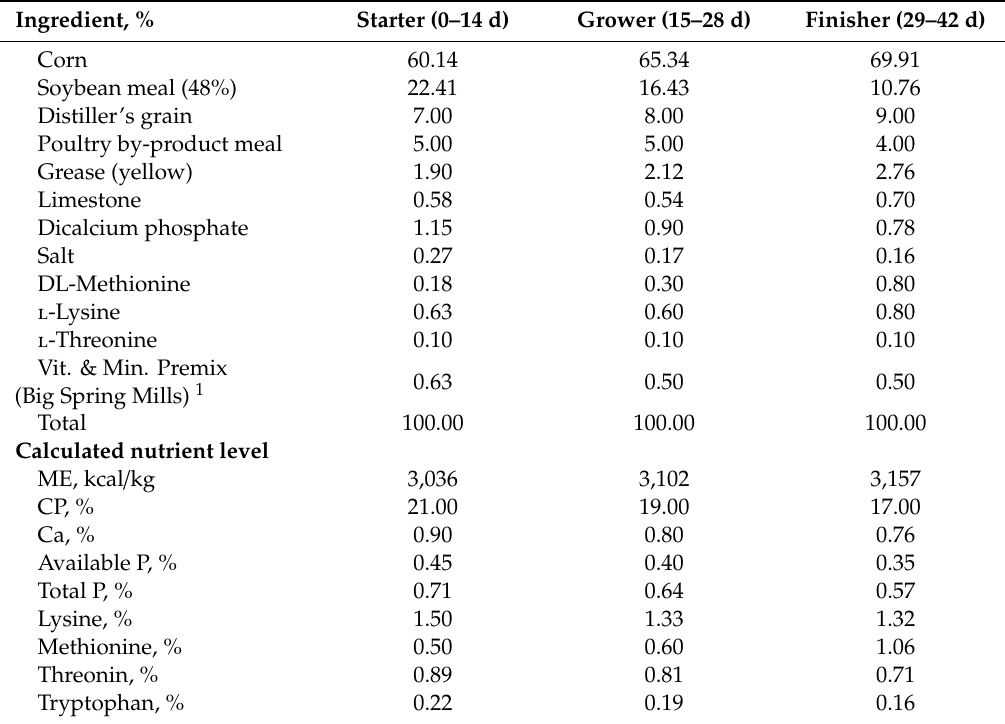
Table 2. Composition and calculated analyses of basal